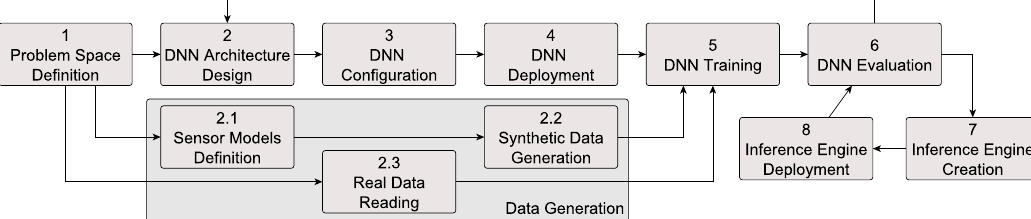
Figure 3. AI Inference Engines design, training and evaluation workflow within Elektrobit (EB)-AI. The workflow builds on top of the proposed data driven V-model from Figure 2.